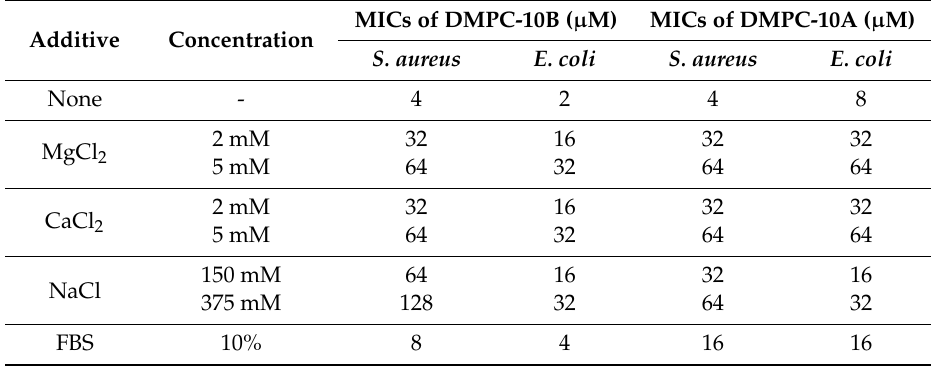
Table 2. Effect of MgCl 2 , CaCl 2 , NaCl and fetal bovine serum (FBS) on the antimicrobial activity of